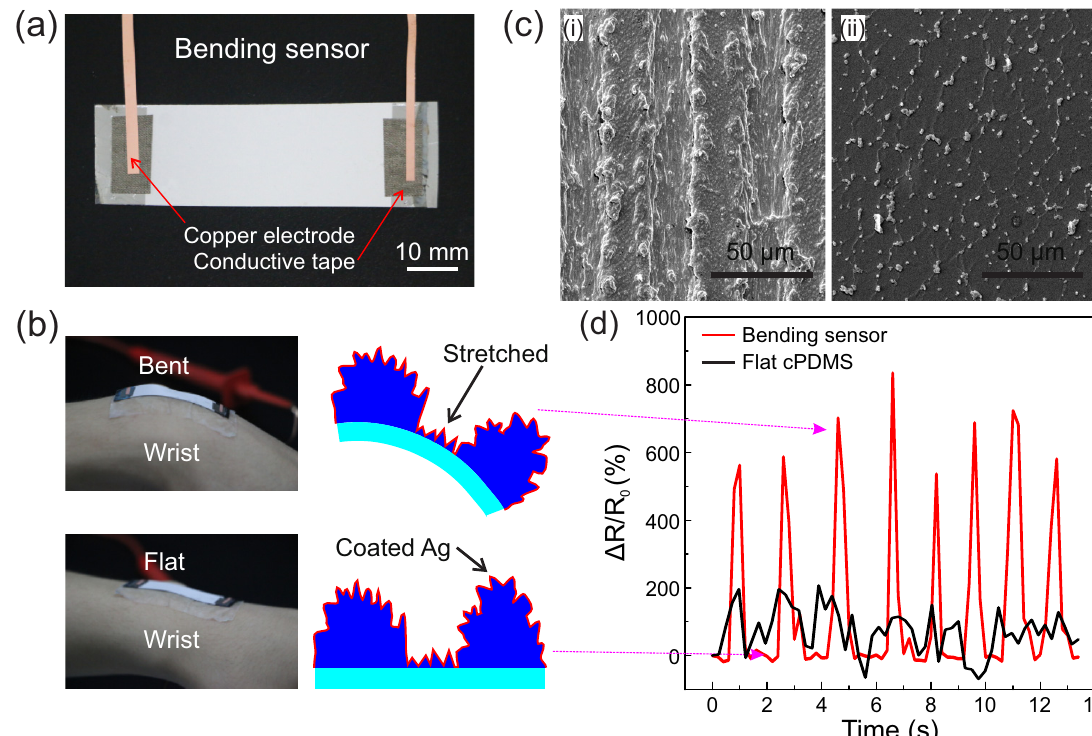
Figure 6. Demonstration of bending sensor with broccoli ‐ like hierarchical micro–nano structures. ( a ) A cPDMS bending sensor with hierarchical micro–nano structures coated with a 100 nm thick layer of Ag. ( b ) The bending sensor and the corresponding micro ‐ schematics. ( c ) FSEM views of the bending sensor ( i ) compared with the flat cPDMS ( ii ) after a bending test. ( d ) The relative resistance rate of the bending sensor (the red curve) laminated on the wrist under dynamic motions compared with that of the flat cPDMS (the black curve).